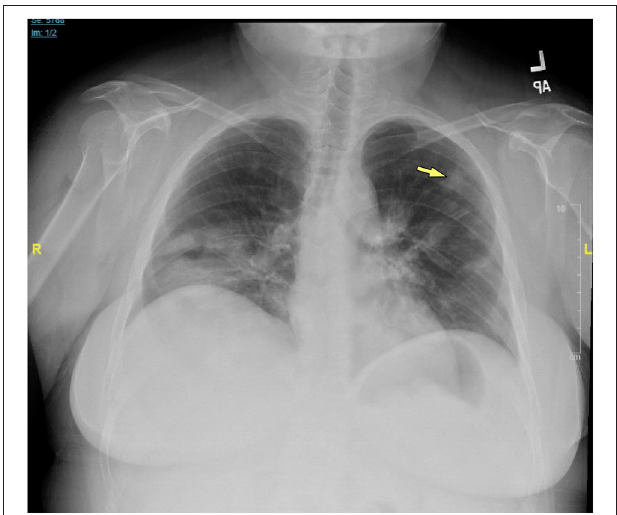
FIGURE 2 | Chest x-ray of CVID/ILD patient demonstrating presence of 1.6cm lesion in the left upper lobe (yellow arrow), as well as patchy densities in the mid to lower lung fields.